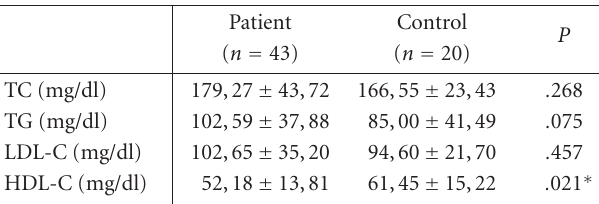
Table 3: Plasma lipids and lipoproteins in patients with psoriasis and control subjects for females.